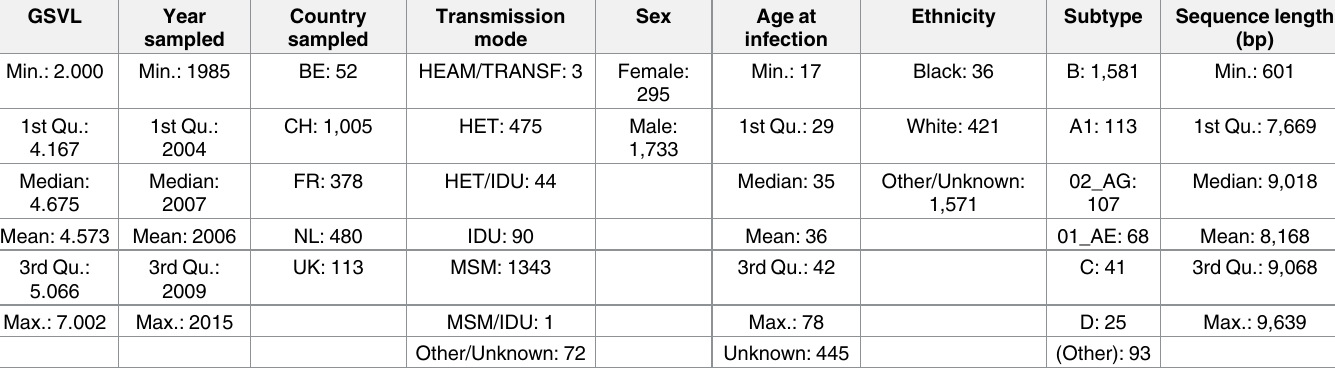
Table 3. Summaryof the main characteristics of the